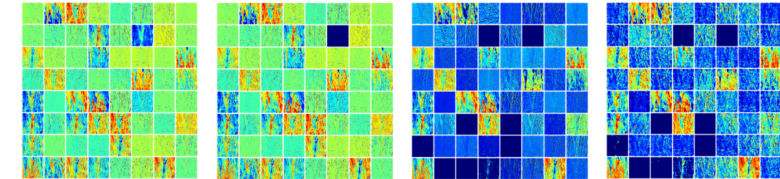
Figure 18. Visualization of shallow feature maps.